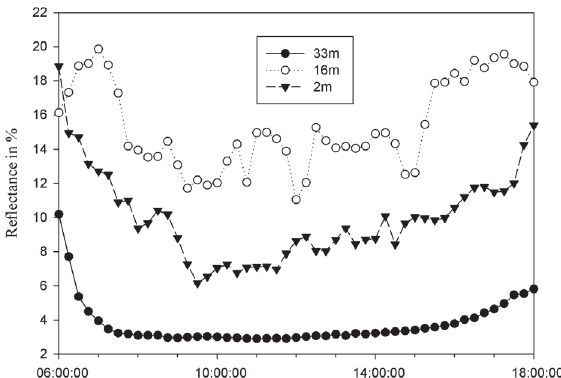
Figure 7 - Mean hourly reflectance of PAR in the rainy season within the forest canopy (16 m and 2 m) and above the forest canopy (33 m).